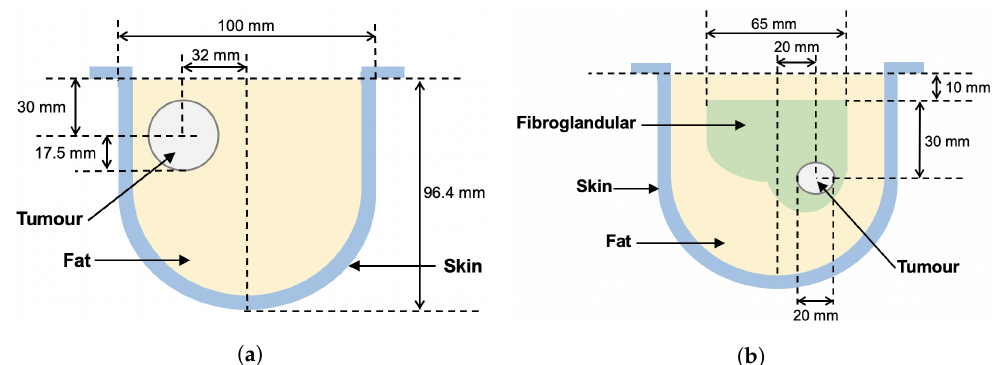
Figure 5. Breast phantom schematic diagrams. Measured positions of tissue regions are approximate. ( a ) Phantom 1. ( b ) Phantom